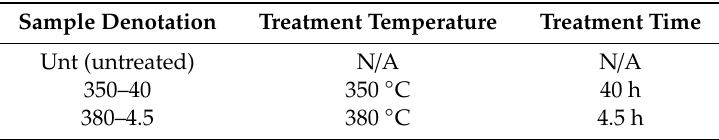
Table 1. Sample denotation and treatment